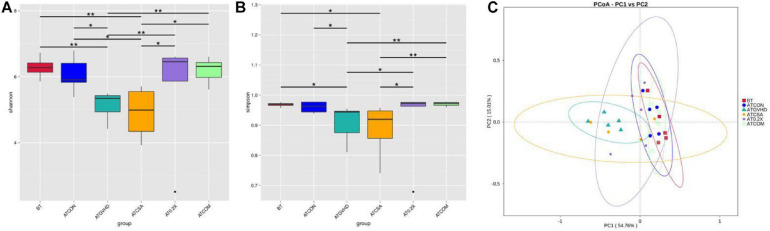
Combination treatment normalized gut microbiota of aGVHD mice. (A) Shannon index of alpha diversity was examined by 16S high-throughput sequencing on day 7 in the GVHD, control, and different treatment groups. n = 4–6/group. Statistical significances are indicated: The Wilcoxon rank-sum test. The top and bottom boundaries of each box indicate the 75th and 25th quartile values, respectively, and lines within each box represent the 50th quartile (median) values. Ends of whiskers mark the lowest and highest diversity values in each instance. (B) Simpson index of alpha diversity was examined by 16S high-throughput sequencing on day 8 in GVHD, control, and different treatment groups. n = 4–6/group. (C) Weighted UniFrac-based principal coordinates analysis (PCoA). The principal component was used to measure the shift of the intestinal bacterial composition structure in different groups of mice after BM transplantation at day 8. n = 4–6/group. BT, samples from mice without BM transplantation; ATCON, samples from BALB/c mice transplanted with BM from C57 donors only; ATGVHD, samples from BALB/c mice transplanted with BM and splenocytes from C57 donors; ATCSA, samples from BALB/c mice transplanted with BM and splenocytes from C57 donors treated with 5 mg/kg CsA; AT0.2X, samples from BALB/c mice transplanted with BM and splenocytes from C57 donors treated with 0.2 mL/kg XBJ; ATCOM, samples from BALB/c mice transplanted with BM and splenocytes from C57 donors treated with 2.5 mg/kg CsA and 0.5 mL/kg XBJ. *,**Compared with aGVHD group.